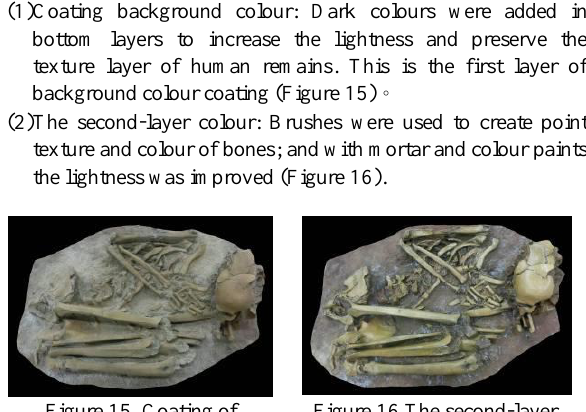
Figure 15. Coating of background colour.